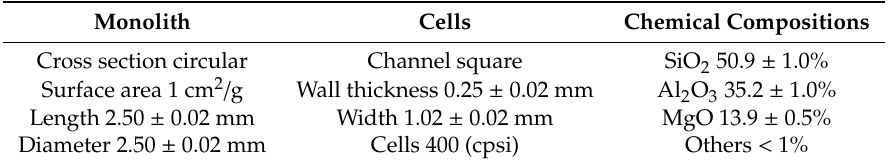
Table 1. Specification of bare